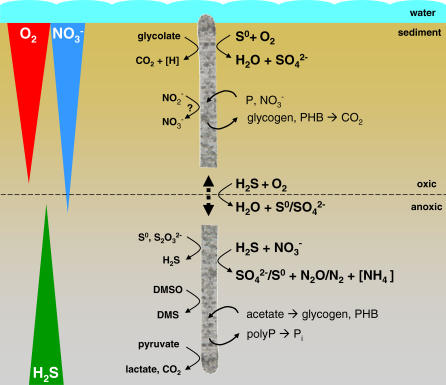
Scheme Summarizing Potential Energy-Yielding Pathways in Beggiatoa in Vertical Gradients of Oxygen, Nitrate, and Hydrogen Sulfide in Marine Surface SedimentInspired by [11,14]. DMS, dimethyl sulfide; PHB, poly-β-hydroxybutyric acid.